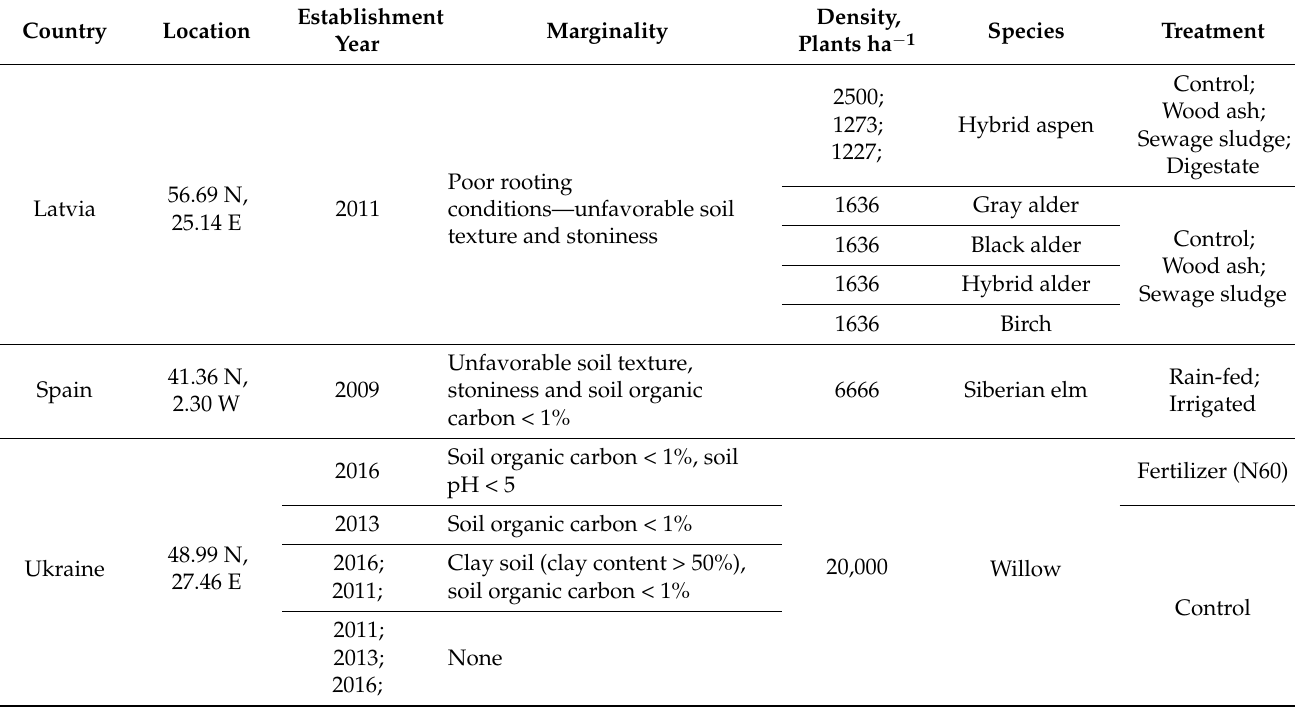
Table 2. Summary of case study design considered in this